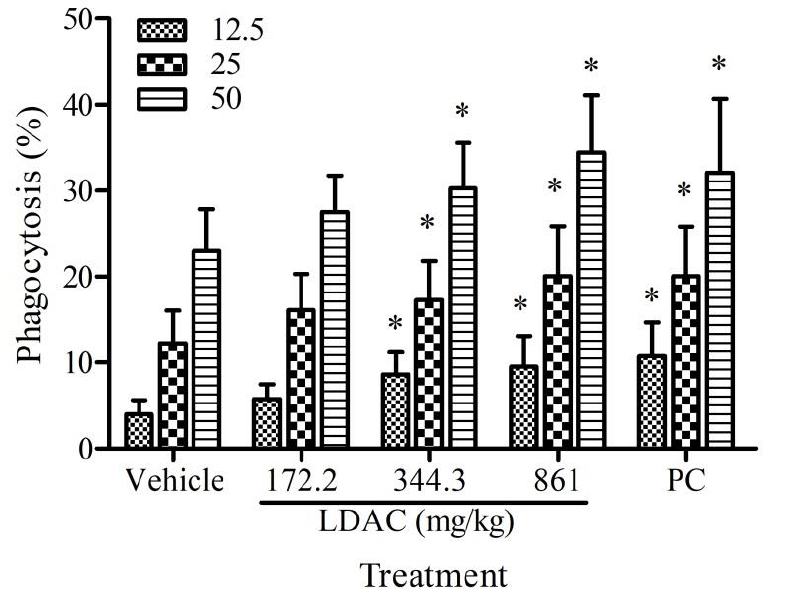
Figure 2. Effect of LDAC on phagocytic cell activity. The mice were administered with LDAC (172.2, 344.4, 861 mg/kg) and positive control (PC, 633.5 mg/kg) for 6 weeks. The peritoneal macrophages were isolated from mice and incubated with fluorescein-labeled E. coli at a multiplicity of infection (MOI) of 12.5–50. The ratio of phagocytosis was determined by flow cytometry. All data are presented as mean ± SD. * p < 0.05 compared to vehicle control.